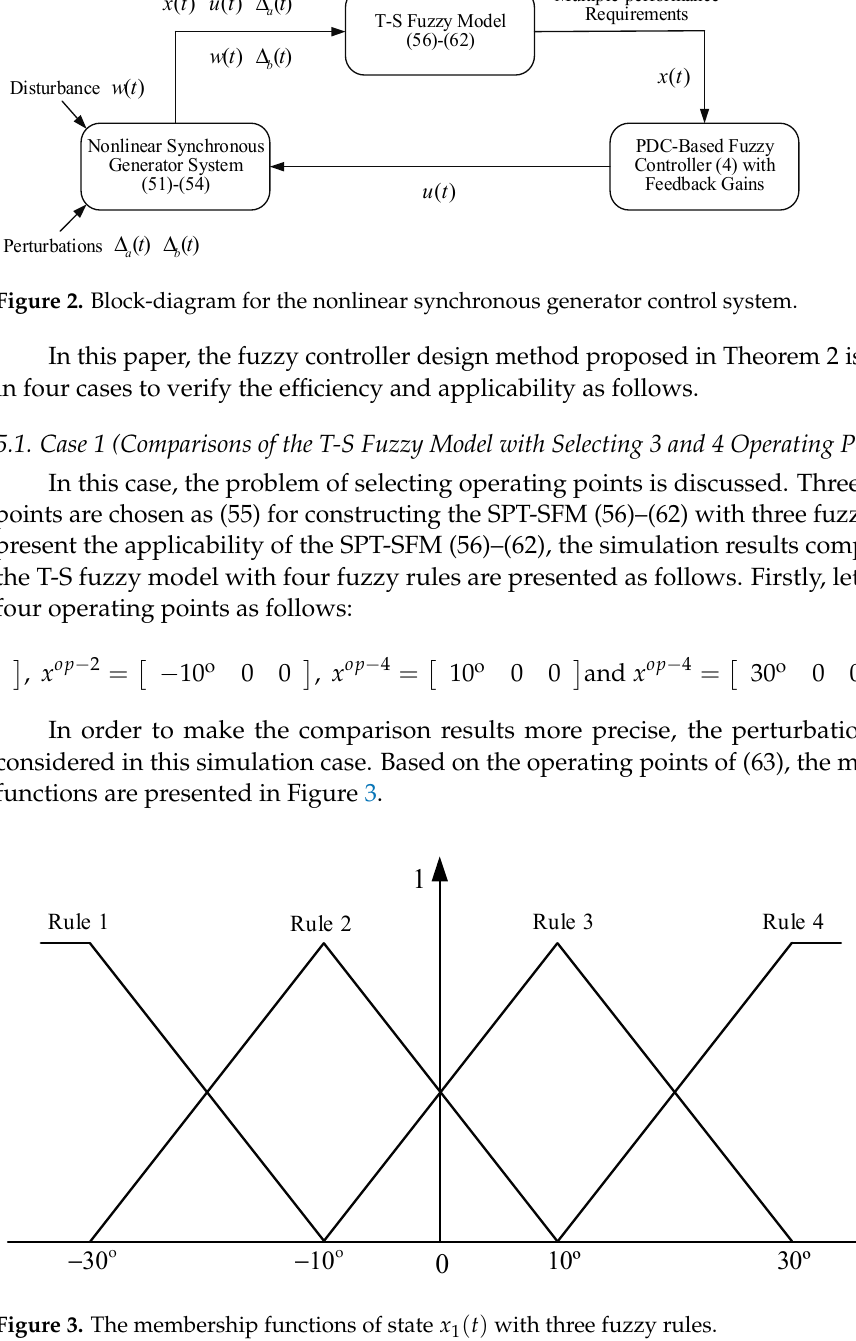
Figure 3. The membership functions of state x 1 ( t ) with three fuzzy rules.